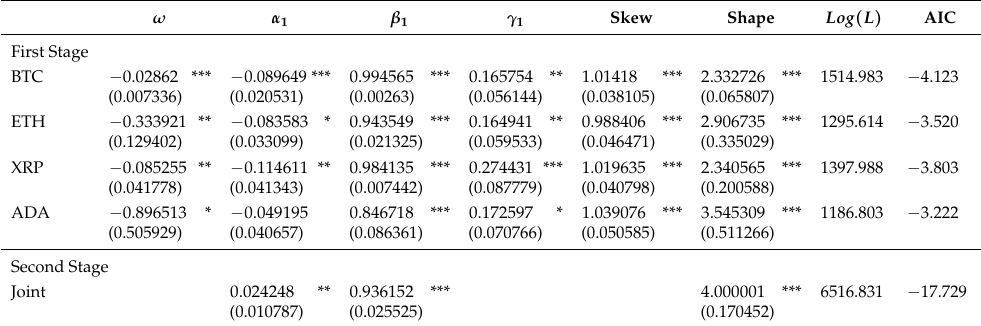
Table 6. Results from multivariate EGARCH (DCC)